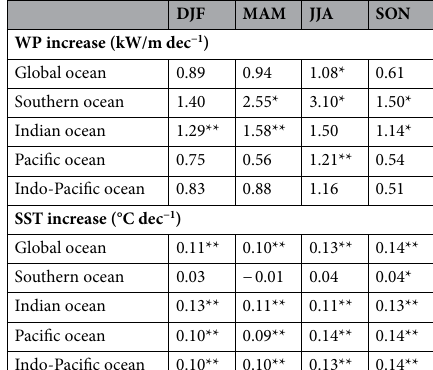
Table 1. Linear trends in the seasonal WP and SST over the period 1979–2019. Statistically significant increases at the 95% and 99% level of confidence are marked with * and **,